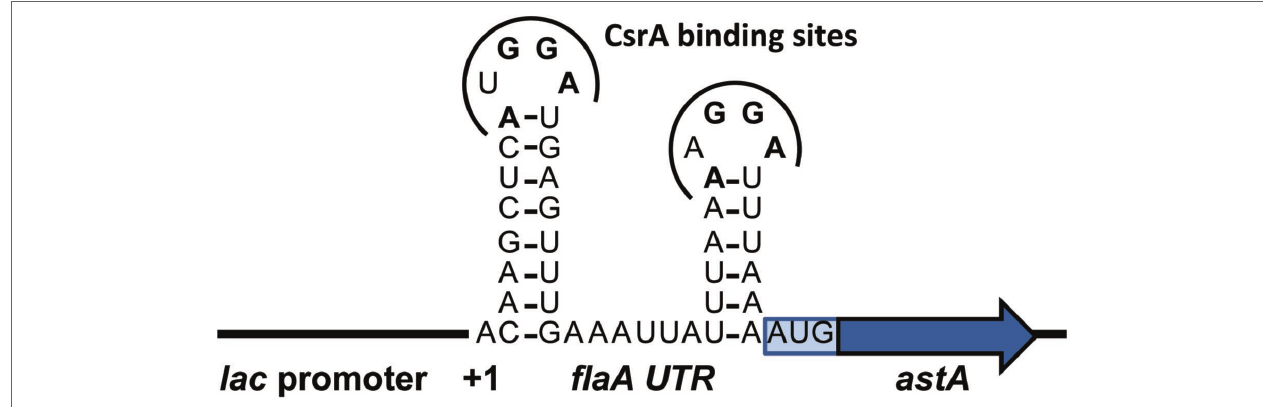
FIGURE 4 | Schematic of translational reporter construct pJOFE. The C. jejuni reporter gene astA was cloned downstream of DNA encoding the flaA 5 ′ UTR to create a translational fusion under the control of the E. coli lac promoter, then the construct was cloned into pACYC184 to yield pJOFE. The 5 ′ UTR of flaA is predicted to fold into two stem-loops with two CsrA-binding sites containing the A(U/A)GGA motif.